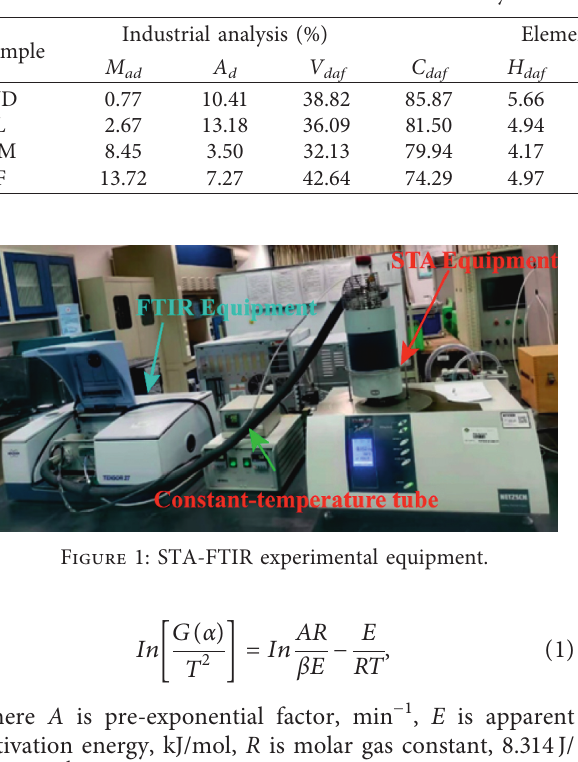
algorithm-based intrinsic reaction coordinate (IRC) method